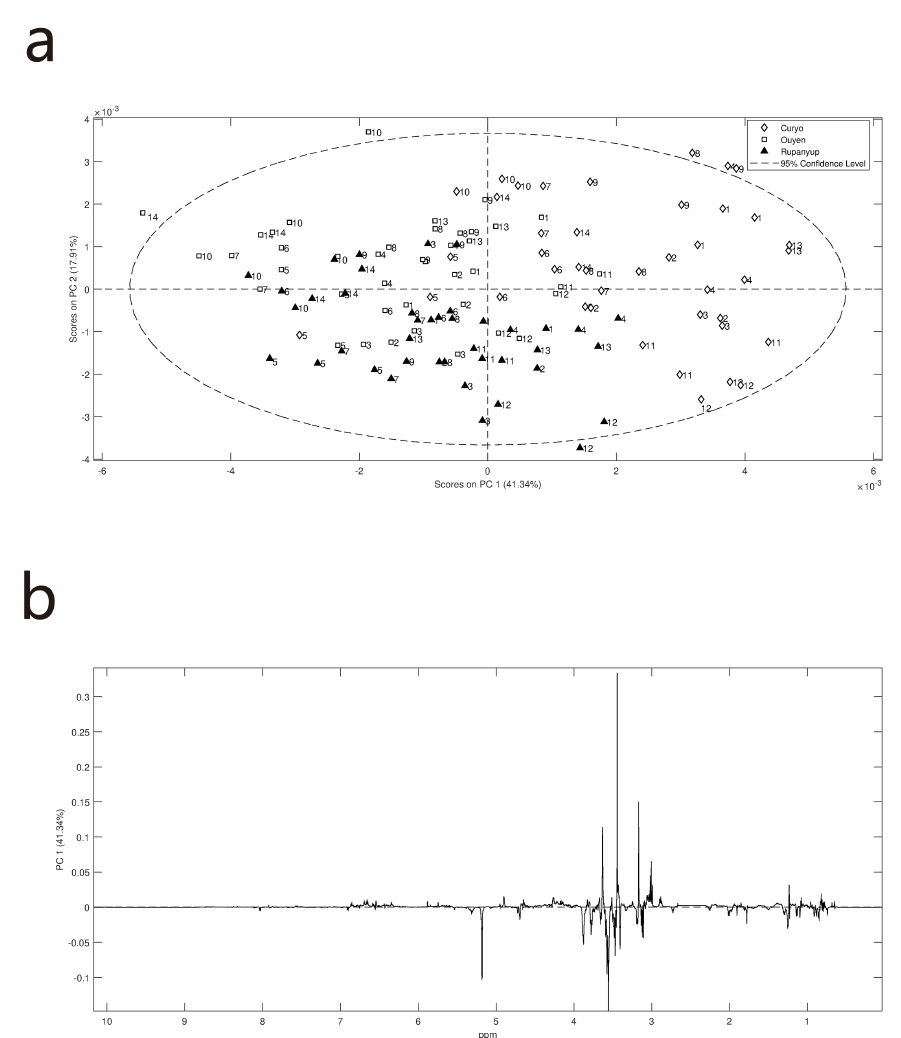
Figure 5. PCA scores and loading plots for 1 H NMR data of lentil hulls: ( a ) PCA scores plot showing some separation based on site and genotype in PC1 (1 = CIPAL1301, 2 = CIPAL1422, 3 = CIPAL1504, 4 = CIPAL1521, 5 = CIPAL1522, 6 = CIPAL1602, 7 = PBA Ace, 8 = PBA Bolt, 9 = PBA Flash, 10 = PBA Giant, 11 = PBA Greenfield, 12 = PBA HurricaneXT, 13 = PBA Jumbo, 14 = PBA Jumbo2); ( b ) Loadings plot of PC1 variables suggest that major variation is in carbohydrate levels (3.2–5.2 ppm) with phenolics (6.2–7.3 ppm) and amino acids (branched chain amino acids: Leucine, isoleucine, valine, all 0.8–1.2 ppm) also influencing the